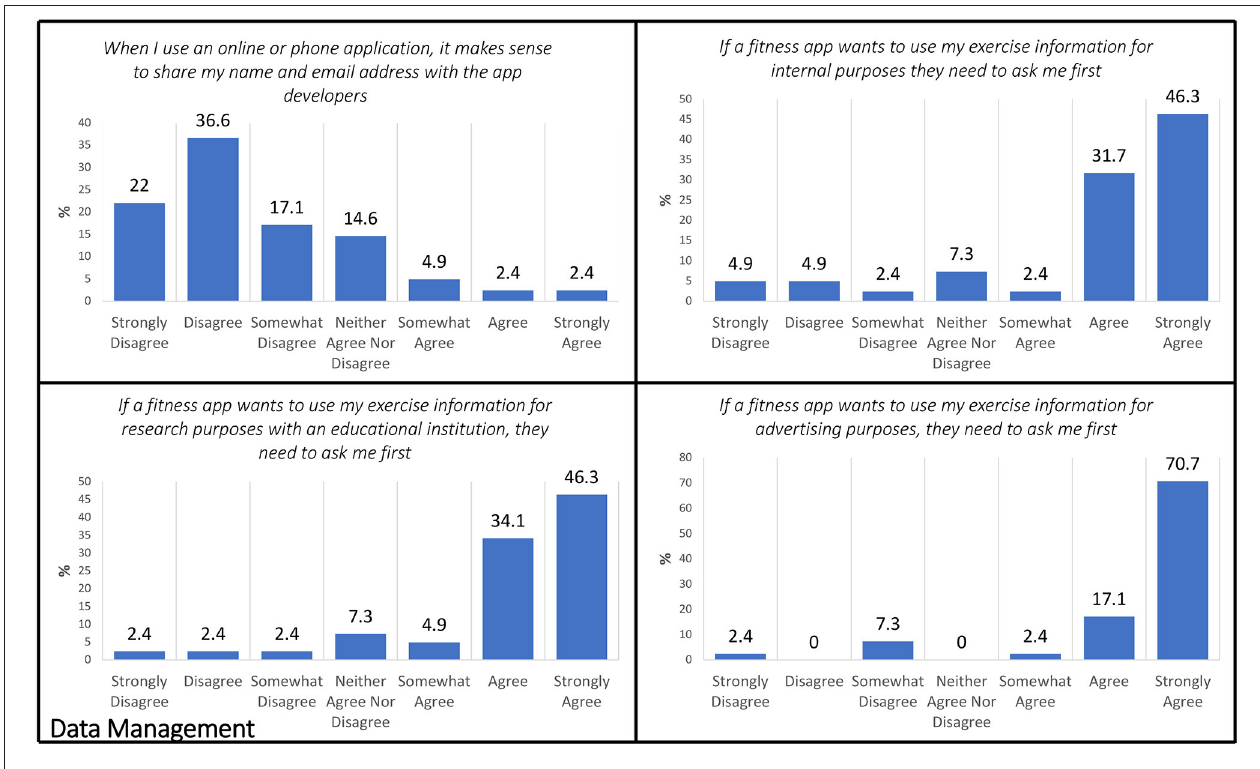
FIGURE 4 | Exit Survey items that aligned with the Data Management domain.